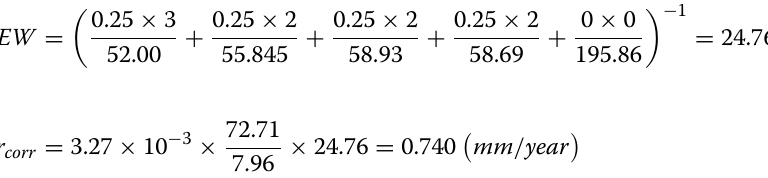
Table 4 Electrochemical corrosion parameters of the (CrFeCoNi) Sample E corr.